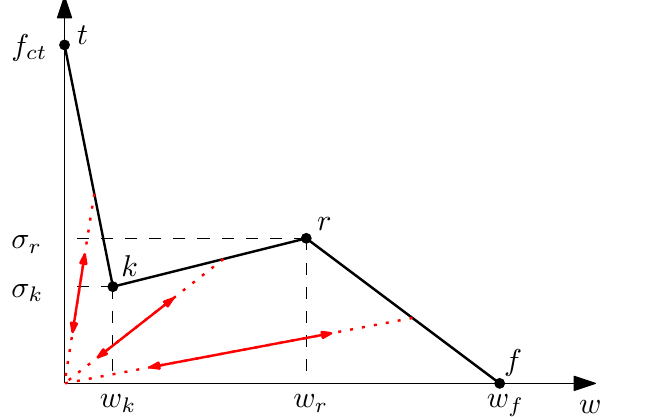
Figure 3. Scheme of a trilinear softening function. Load–unload branches follow a line towards the origin.